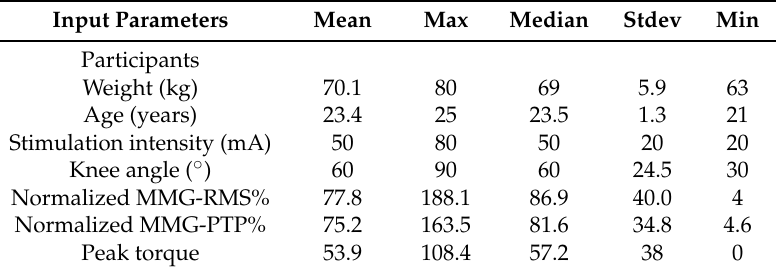
Table 3. Statistical parameters of the datasets.